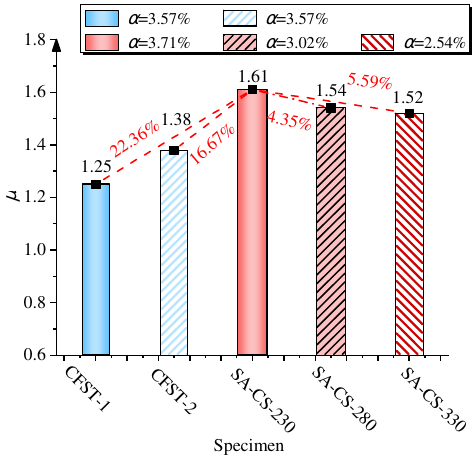
Figure 10. Ductility index of specimens.